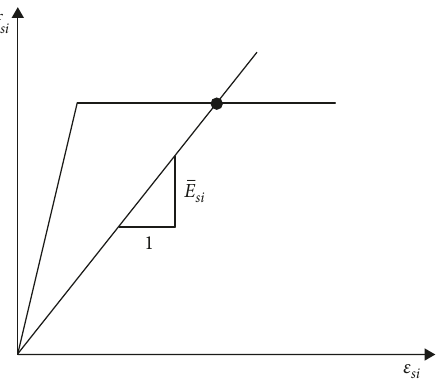
Figure 6: Reinforcement stress-strain response.